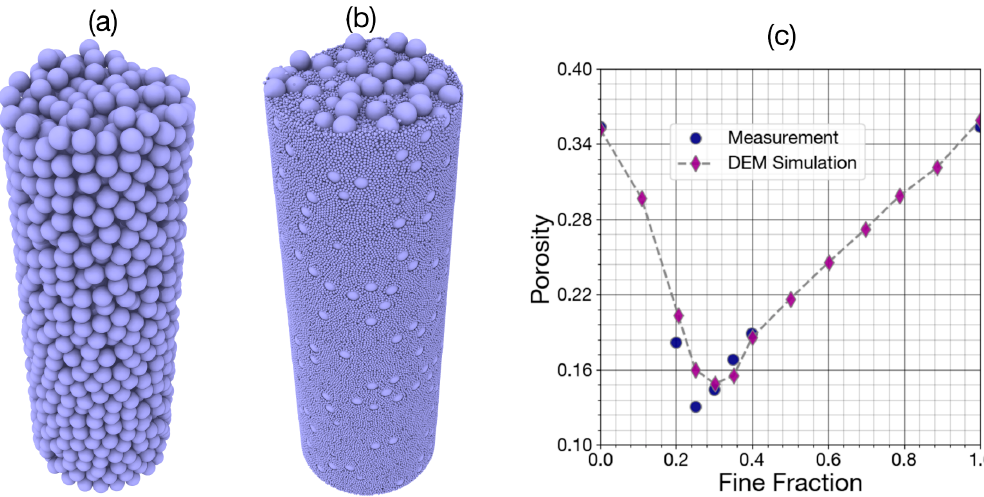
Figure 6. Porosity of packing of binary mixtures of spheres with size ratio (d / D) 0.14 in comparison with McGeary’s measurement [40] ( a ) pure coarse grain, ( b ) fine sediment fraction 0.4, and ( c ) porosity of mixture. Table 2. Statistical performance of porosity simulation using